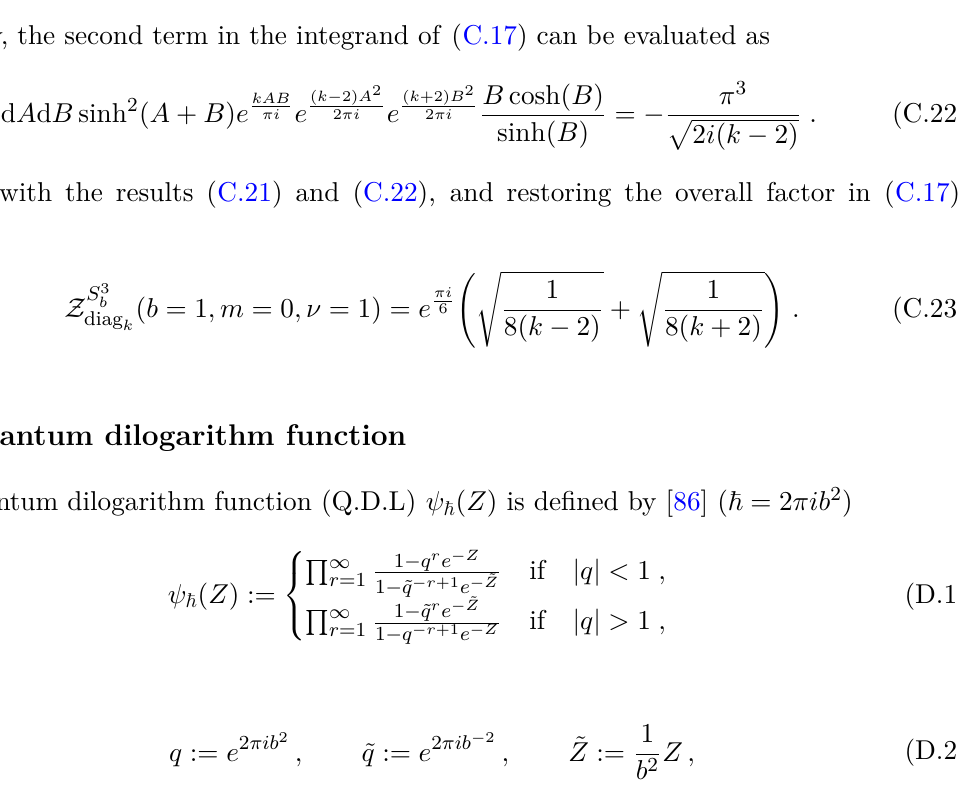
Figure 6 . A path l 3 for (C.20). There are simple poles at A = 0 , ± πi